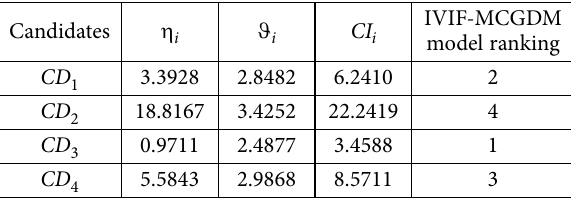
Table 8. Computational results of the